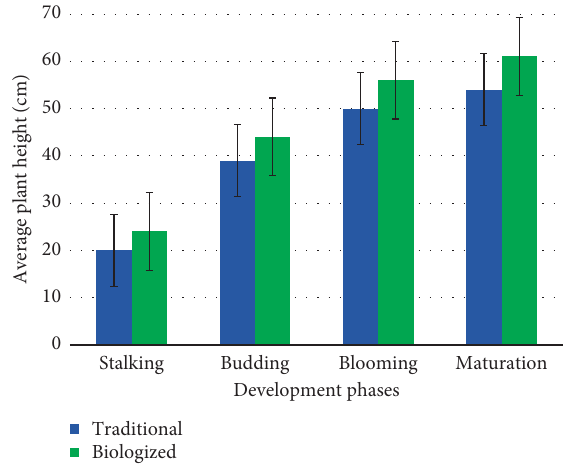
Figure 3: Dynamics of safflower growth depending on cultivation technology